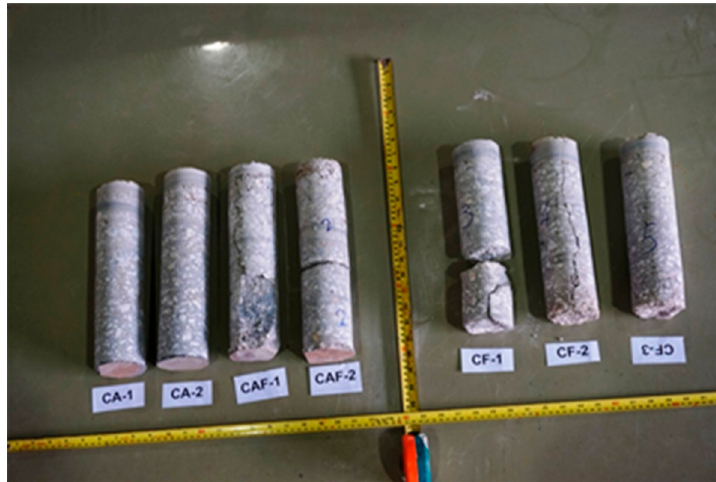
Figure 11. The sample cores, 100 mm in diameter, taken out from slabs.